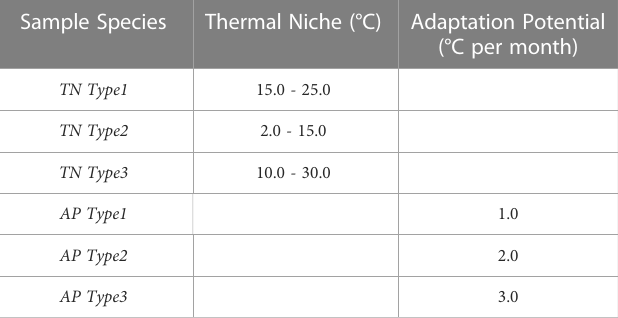
TABLE 2 The sample thermal constraints settings for which connectivity was computed in this study.